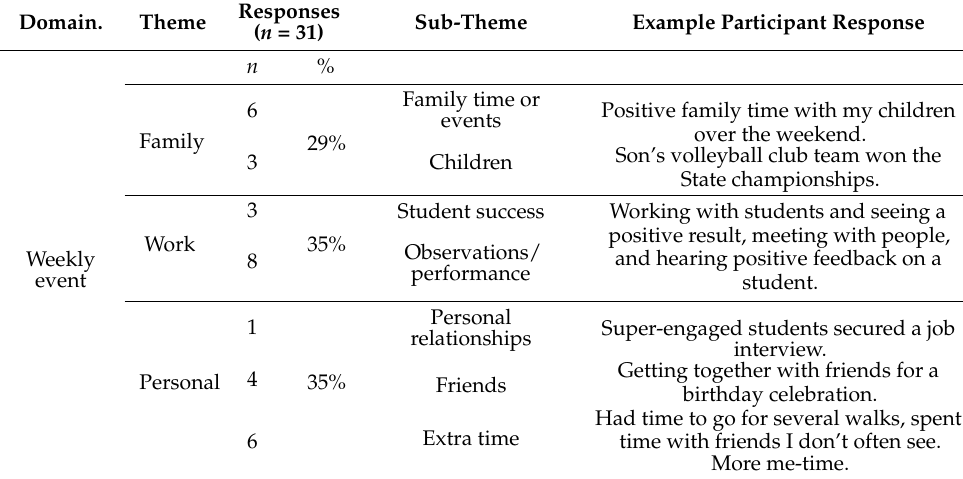
Table 5. Participant weekly reflection positive events.